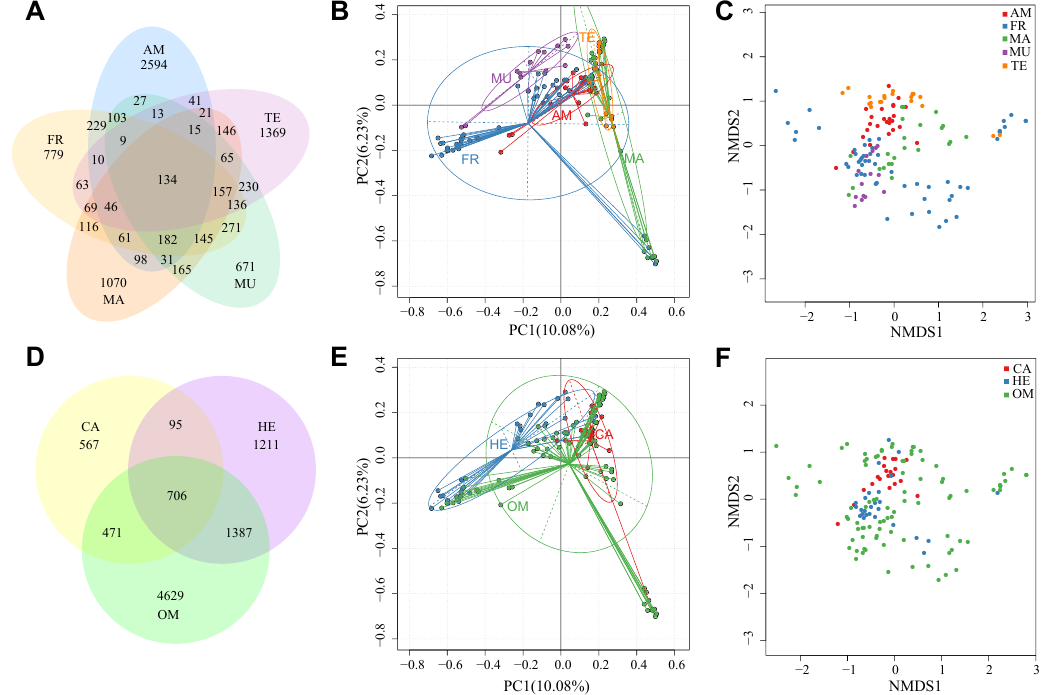
Figure 2. An operational taxonomic unit (out) analysis among the five vertebrate groups. ( A ) Venn diagram displaying the numbers of common and unique OTUs; ( B ) principal component analysis (PCA) diagram and ( C ) non-metric multi-dimensional scaling (NMDS) analyses were employed to distinguish the examined five groups with different living habitats; ( D ) Venn diagram displaying the numbers of common and unique OTUs among the three animal groups with different feeding habits; ( E ) PCA diagram and ( F ) NMDS analyses were used to separate them. OM, omnivore; HE, herbivore; CA: